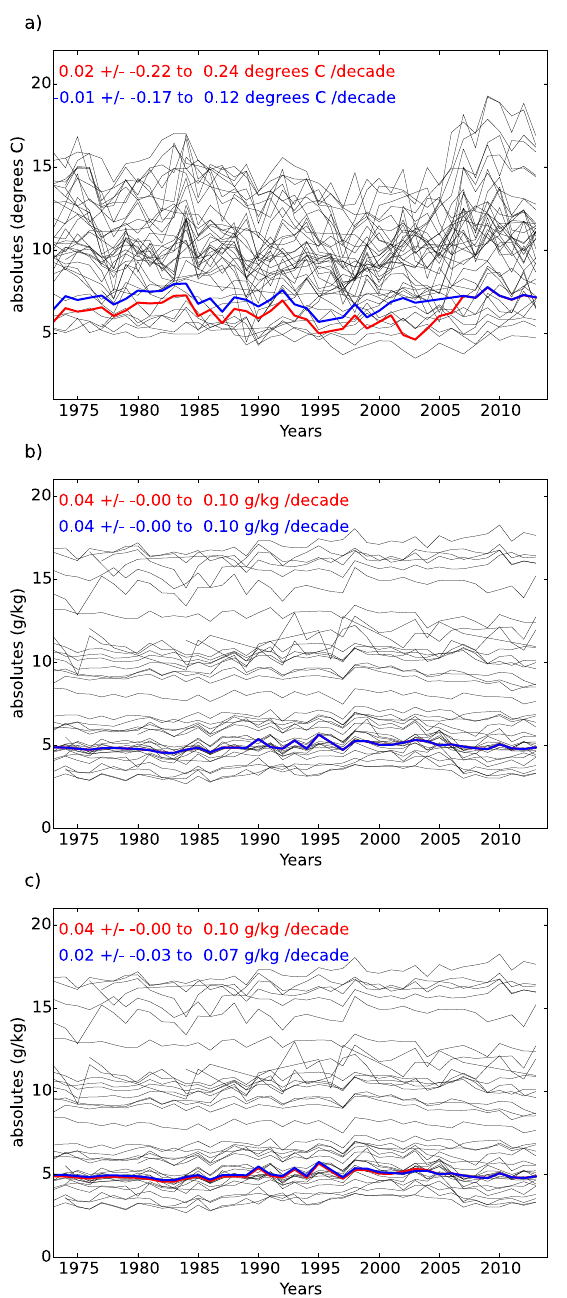
Figure 4. Example of an inhomogeneity having a greater signal- to-noise ratio in DPD compared to q for station 557730, Pagri, Ti- bet. (a) DPD annual mean series for raw data (red) and direct PHA homogenised data (blue) for 557730 and its raw neighbour series (black). (b) q annual mean series for raw data (red) and direct PHA homogenised data (blue) for 557730 and its raw neighbour series (black). (c) q annual mean series for raw data (red) and indirect PHA homogenised data (blue) for 557730 and its raw neighbour series